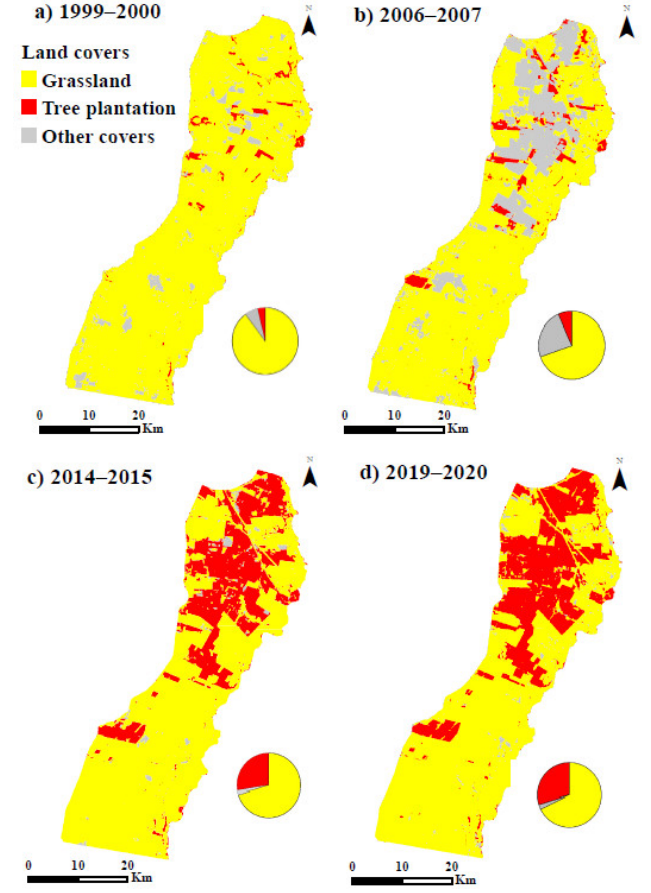
Figure 2. Land cover thematic maps for ( a ) 1999–2000, ( b ) 2006–2007, ( c ) 2014–2015, and ( d ) 2019–2020, based on unsupervised classifications of NDVI time-series datasets derived from Landsat TM ( a , b ) and Landsat OLI images ( c , d ). Pie charts indicate the percentage of each land cover type for each period.